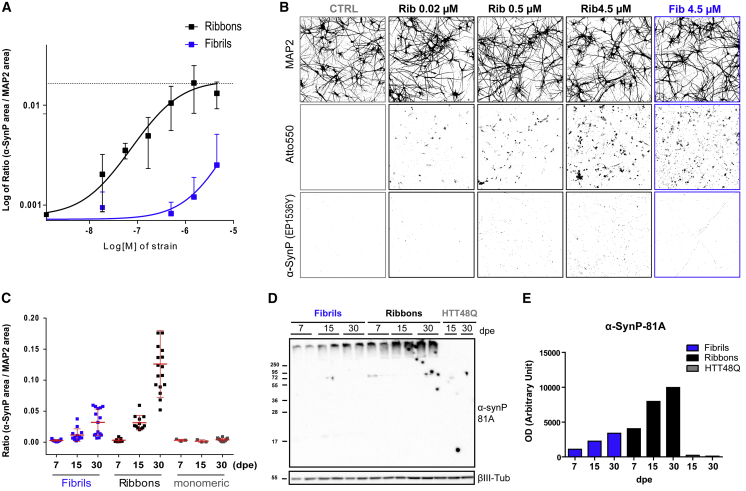
Dose- and Time-Dependent Effect of α-Syn Strain Exposure(A) Ratio (logarithmic scale) between the area occupied by α-SynP and MAP2 at increasing concentration of fibrils and ribbons (0.02 < x < 4.5 μM, 15 dpe; mean ± SD; n = 2).(B) Binary threshold masks of MAP2, Atto-550 assemblies, and α-SynP structures of control neurons (untreated, gray boxed) or neurons exposed at different concentrations of ribbons (black boxed) or fibrils (blue boxed).(C) Ratio between the area occupied by α-SynP and MAP2 over time (7, 15, and 30 dpe; [strains] = 500 nM). Data are shown as mean ± SD, n = 3 (for statistical analysis see Supplemental Information).(D and E) (D) Western blot analysis and (E) quantification showing the progressive accumulation of α-SynP in the insoluble fractions of neuron lysates at 7, 15, and 30 dpe to fibrils, ribbons, or fibrillar HTTExon1Q48 (α-SynP-81A antibody).